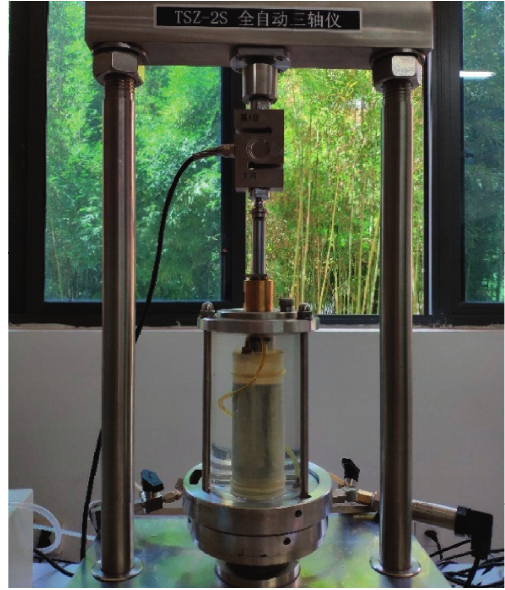
Figure 3: TSZ-2S fully automatic triaxial test apparatus. Table 1: Basic physical properties of the soft soil.